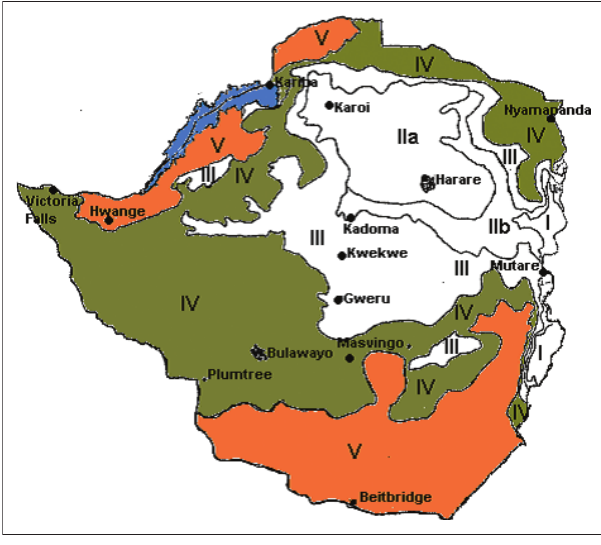
TABLE 1: Biographical data of the respondents.